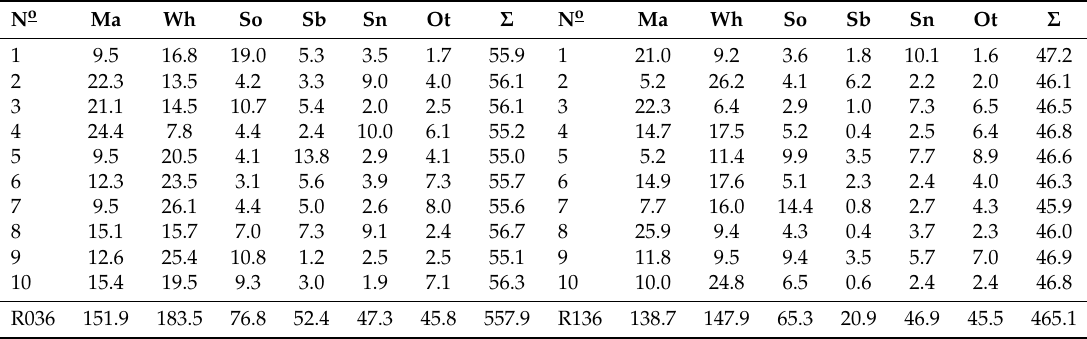
Table 3. Number of labeled pixels in 10 3 per each of the categories of random partition in Table 2.